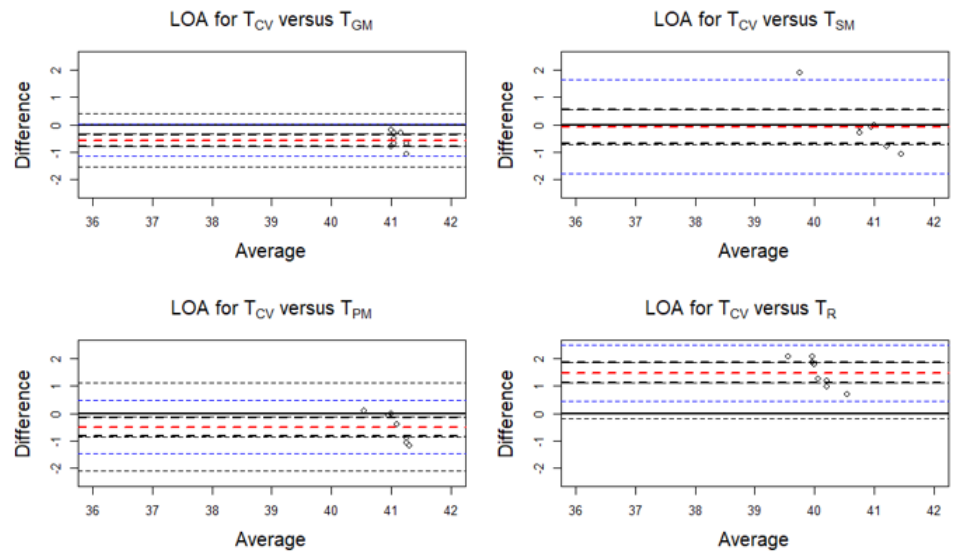
Figure 6. Limits of agreement (LOA) plots for the temperature pairs (T CV / T GM , T CV / T SM , T CV / T PM , and T CV / T R ) during Phase C (immediately after treadmill). The red horizontal dashed line indicates the mean bias. The blue horizontal dashed lines indicate the upper and lower limits. The black horizontal dashed lines indicate the 95% confidence intervals of the LOA. T CV = central venous temperature, T PM = pectoral muscle temperature, T GM = gluteal muscle temperature, T SM = splenius muscle temperature, T R = rectal temperature.